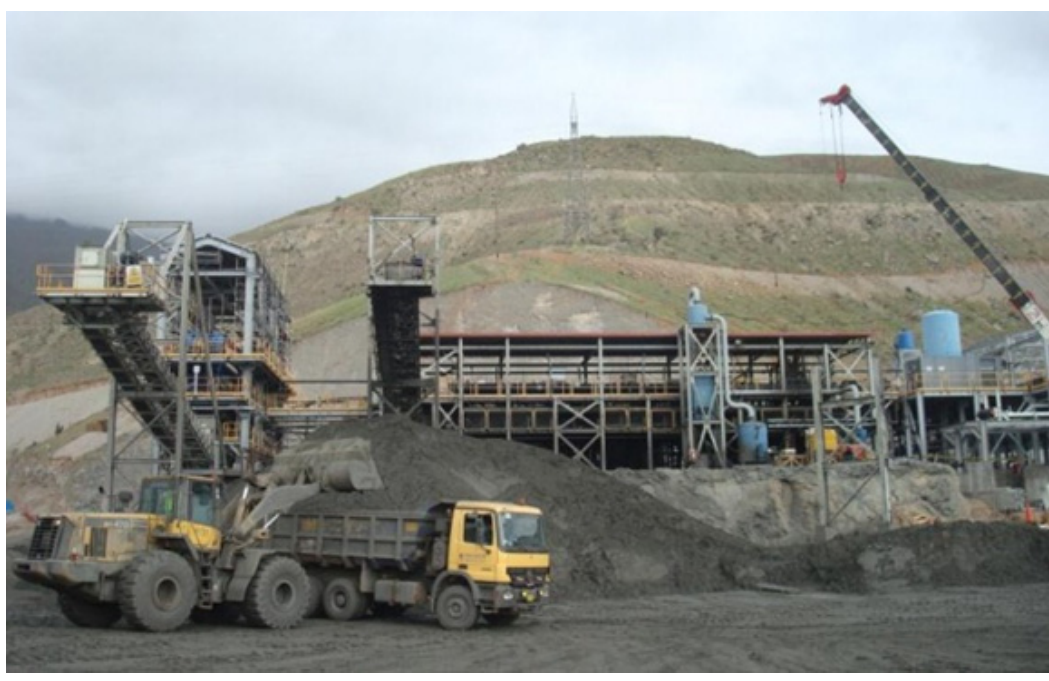
Figure 6. Typical View of Temporary Filtered Tailings Stockpile [20].